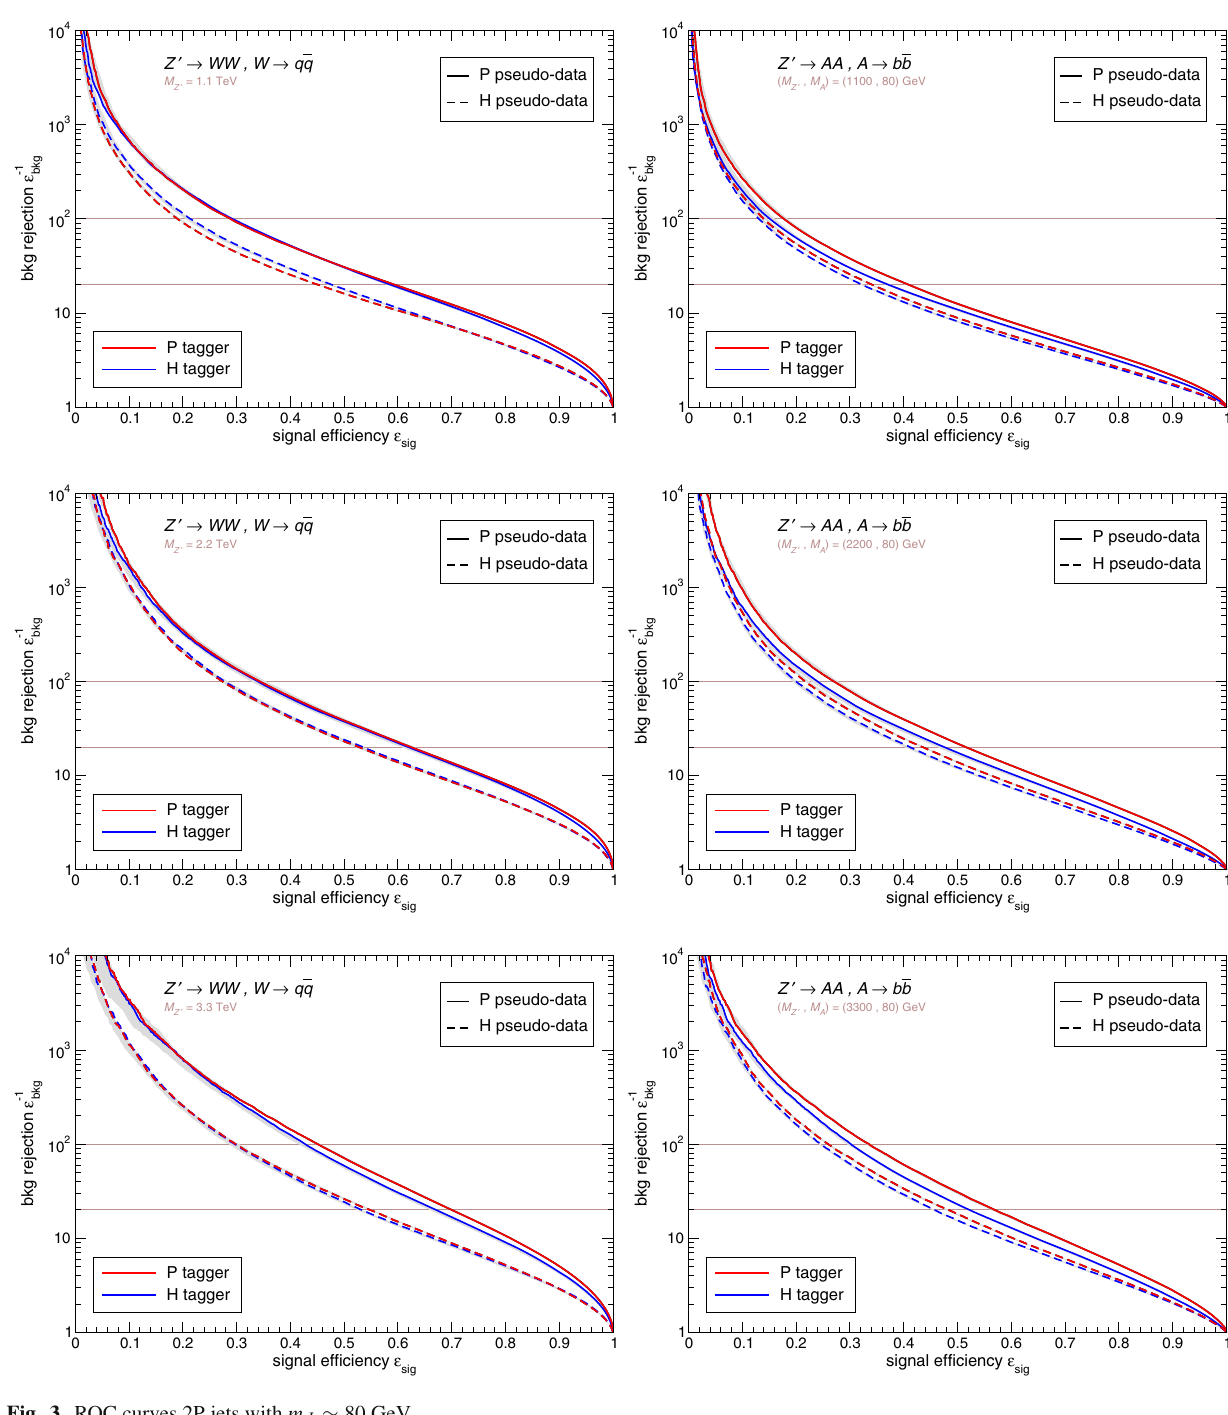
Fig. 3 ROC curves 2P jets with m J ∼ 80 GeV